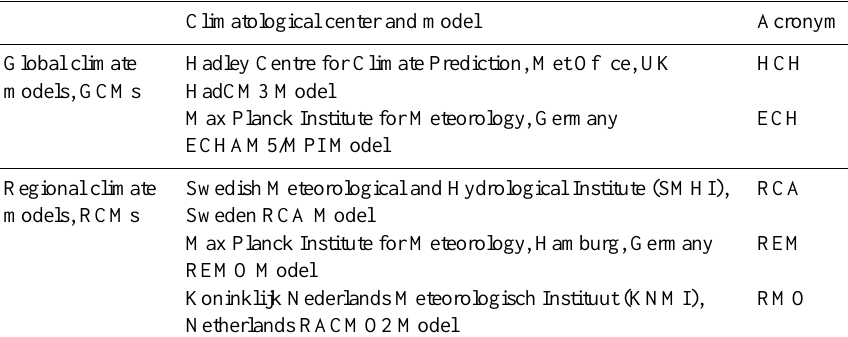
Table 1. List of the GCMs used as drivers of ENSEMBLES RCMs considered in this study together with corresponding climatological center and model, and acronyms adopted. The four GCM–RCM combinations used in this study are ECH–RCA, ECH–REM, ECH–RMO and HCH–RCA.